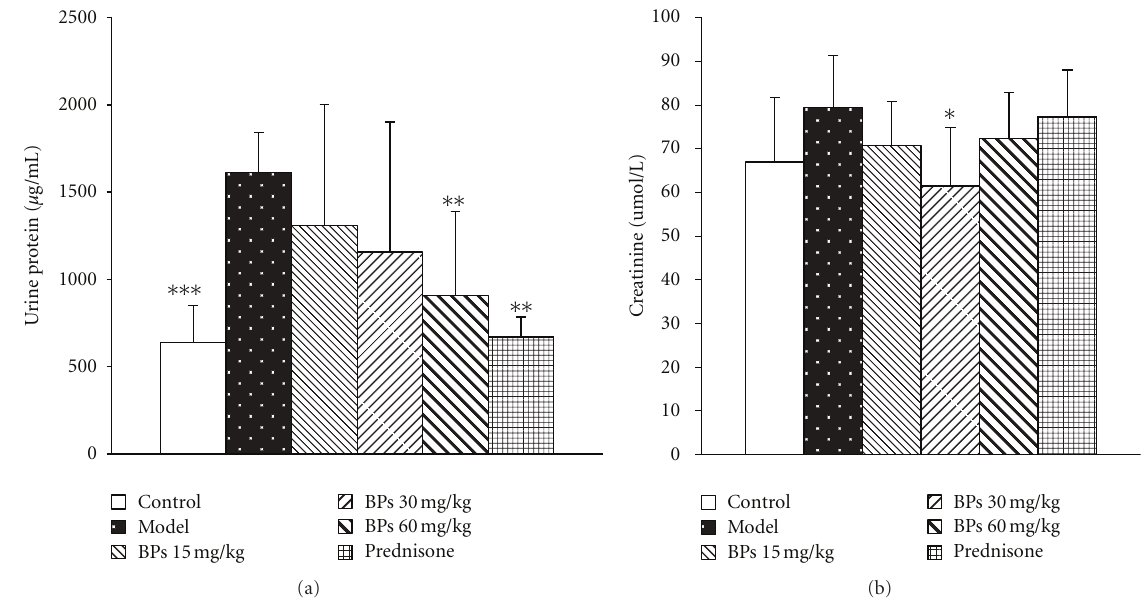
Figure 4: E ff ect of BPs on urinary protein and serum creatinine levels of MRL-lpr and BALB/c mice. MRL-lpr mice were grouped randomly and treated with BPs 15, 30, and 60 mg · kg − 1 · day − 1 , prednisone 5mg · kg − 1 · day − 1 , or model from week 12 to week 24; mice were sacrificed and the supernatant of urine was diluted 1:3 in normal saline; the serum creatinine was measured with Ja ff e method; data were expressed as means ± S.D. ( n = 6–8); ∗ P < 0 . 05, ∗∗ P < 0 . 01, ∗∗∗ P < 0 . 001 compared with vehicle-treated model group, tested by ANOVA and Fisher’s PLSD.